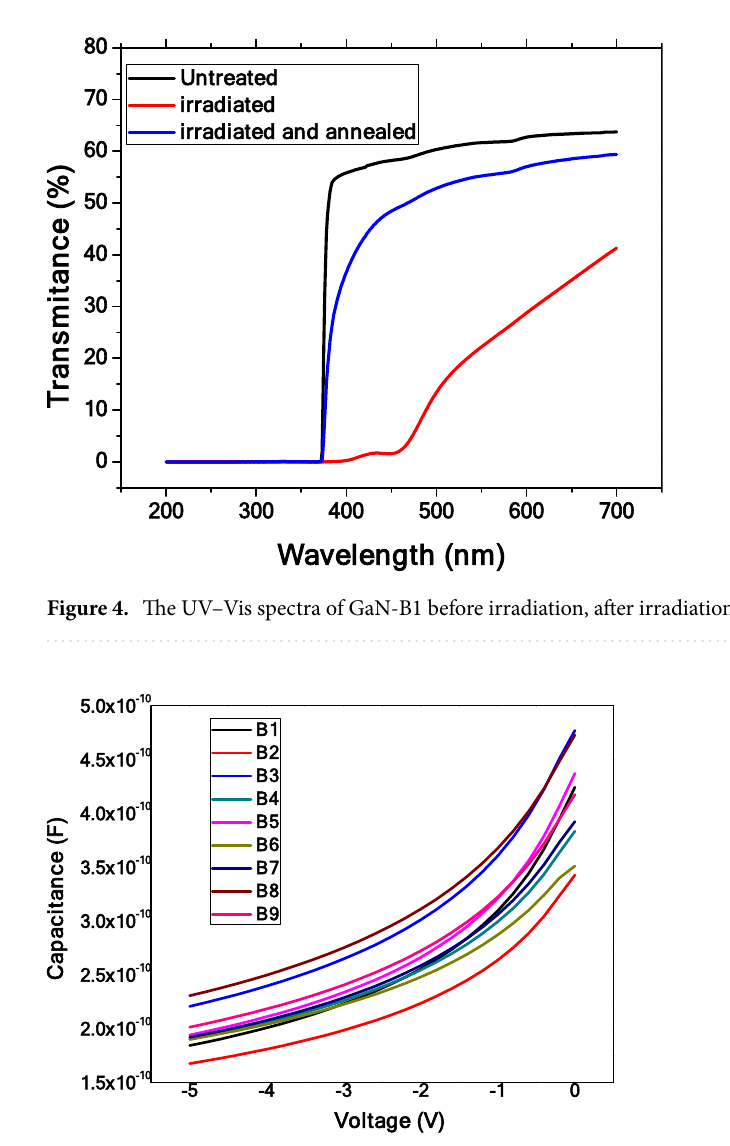
Figure 5. The C-V measurements of GaN 1–10 using mercury